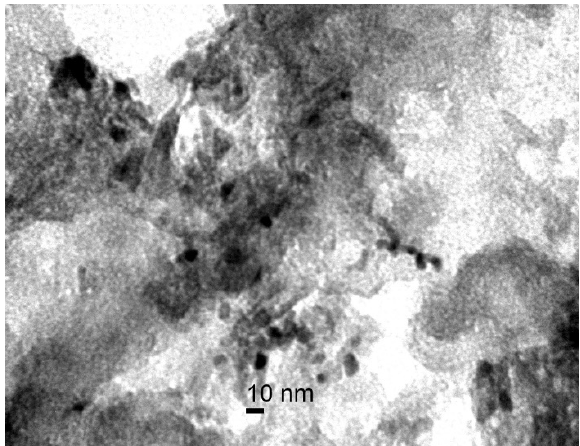
Figure 4. TEM micrograph of MF-4SC membranes + 3 wt.% SiO 2 (5 mol.% R1) obtained via casting procedure [32].